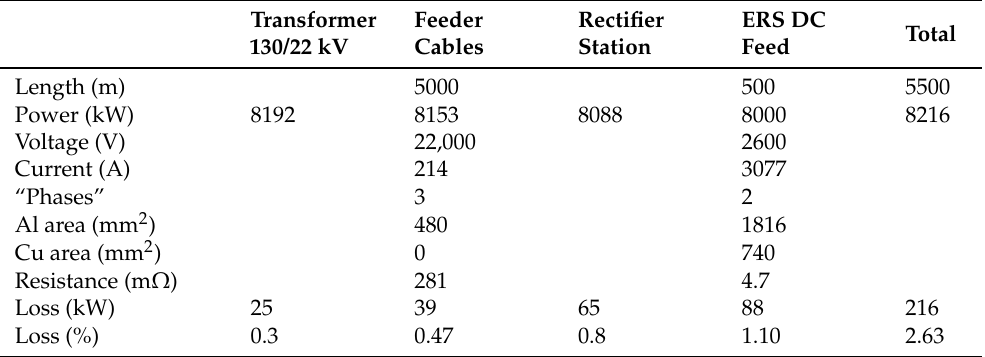
Table 6. Assumptions for power distribution losses in the